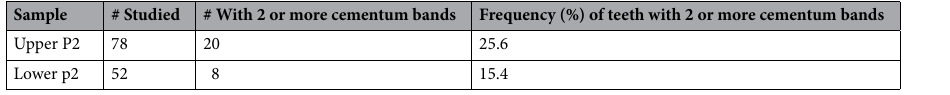
Table 2. Frequency of multiple, well-defined cementum bands in the occlusal/coronal area of upper and lower second premolars in study sample of North American Pleistocene equids.